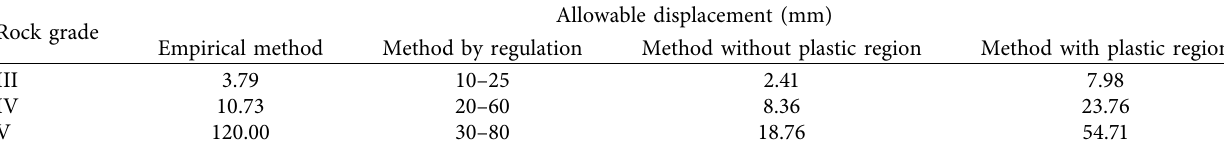
Table 4: Allowable displacement according to different methods.